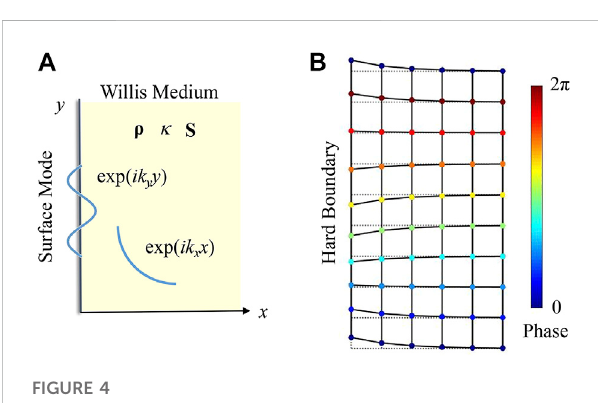
FIGURE 4 (A) Schematic representation of the surface mode of a semi- in fi niteWillismedium. (B) Typicalwavepatternof edgemodefor Willis acoustic media with isotropic